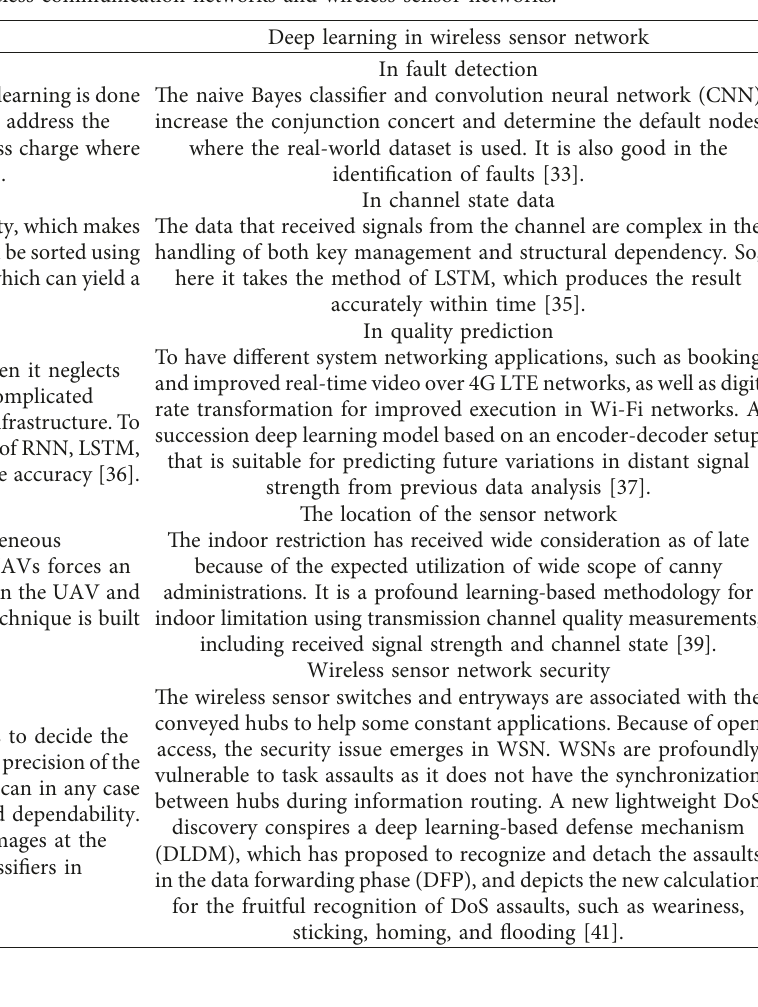
Table 1: Comparison of wireless communication networks and wireless sensor